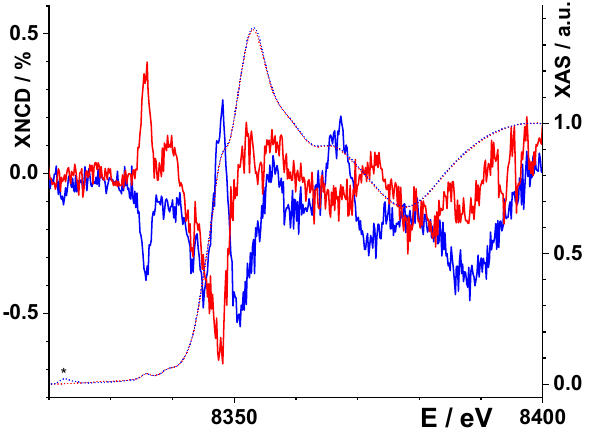
Figure 5. Absorption (dotted lines) and XNCD (full lines) spectra for the ∆ (in red) and Λ (in blue) enantiomers of [Ni 0.2 Zn 0.8 (bpy) 3 ](PF 6 ) 2 . Diffraction peaks are signaled with a *. EDX measurements on one of the enantiomers yielded proportions of Ni 0.133 Zn 0.867 . Assignment of spectra to chiral configurations was made afterward, with measurements performed on two single crystals of [Ni 0.1 Zn 0.9 (bpy) 3 ](PF 6 ) 2 , the absolute configuration of which had been previously assigned by X-ray diffraction (Figure S9 in ESI).